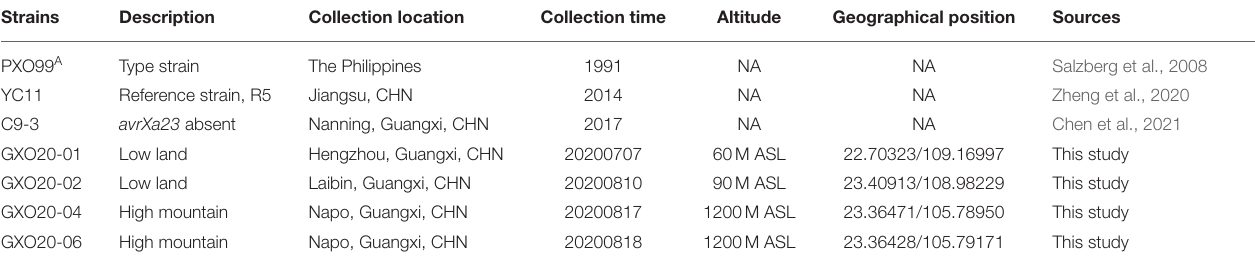
TABLE 1 | Xanthomonas oryzae pv. oryzae strains used in this study.